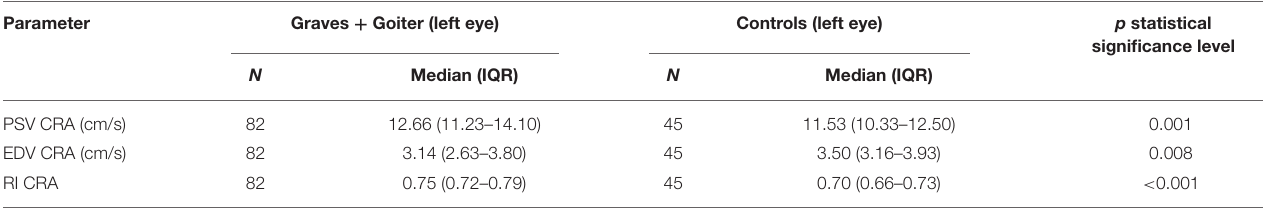
TABLE 3 | Comparison of blood flow parameters (PSV, EDV, RI) in central retinal artery in hyperthyroid patients and healthy controls.